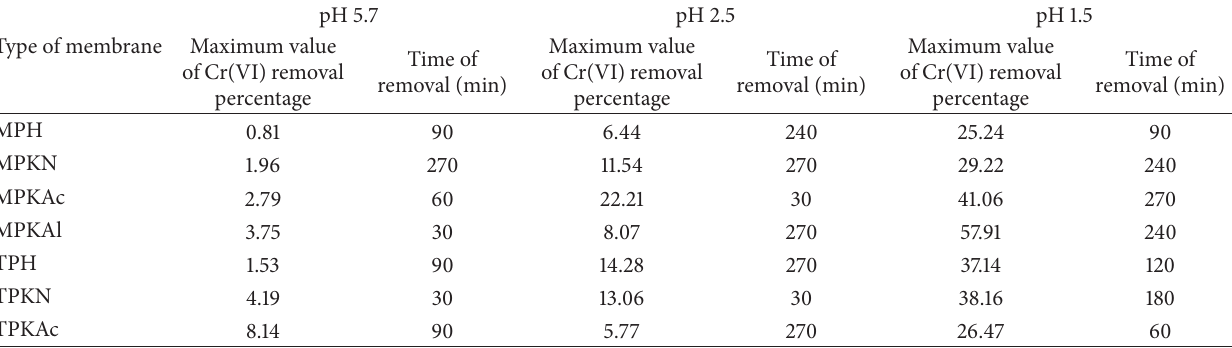
Table 2: Maximum values of Cr(VI) removal percentages through filtration process with PU-keratin membranes as function of pH.